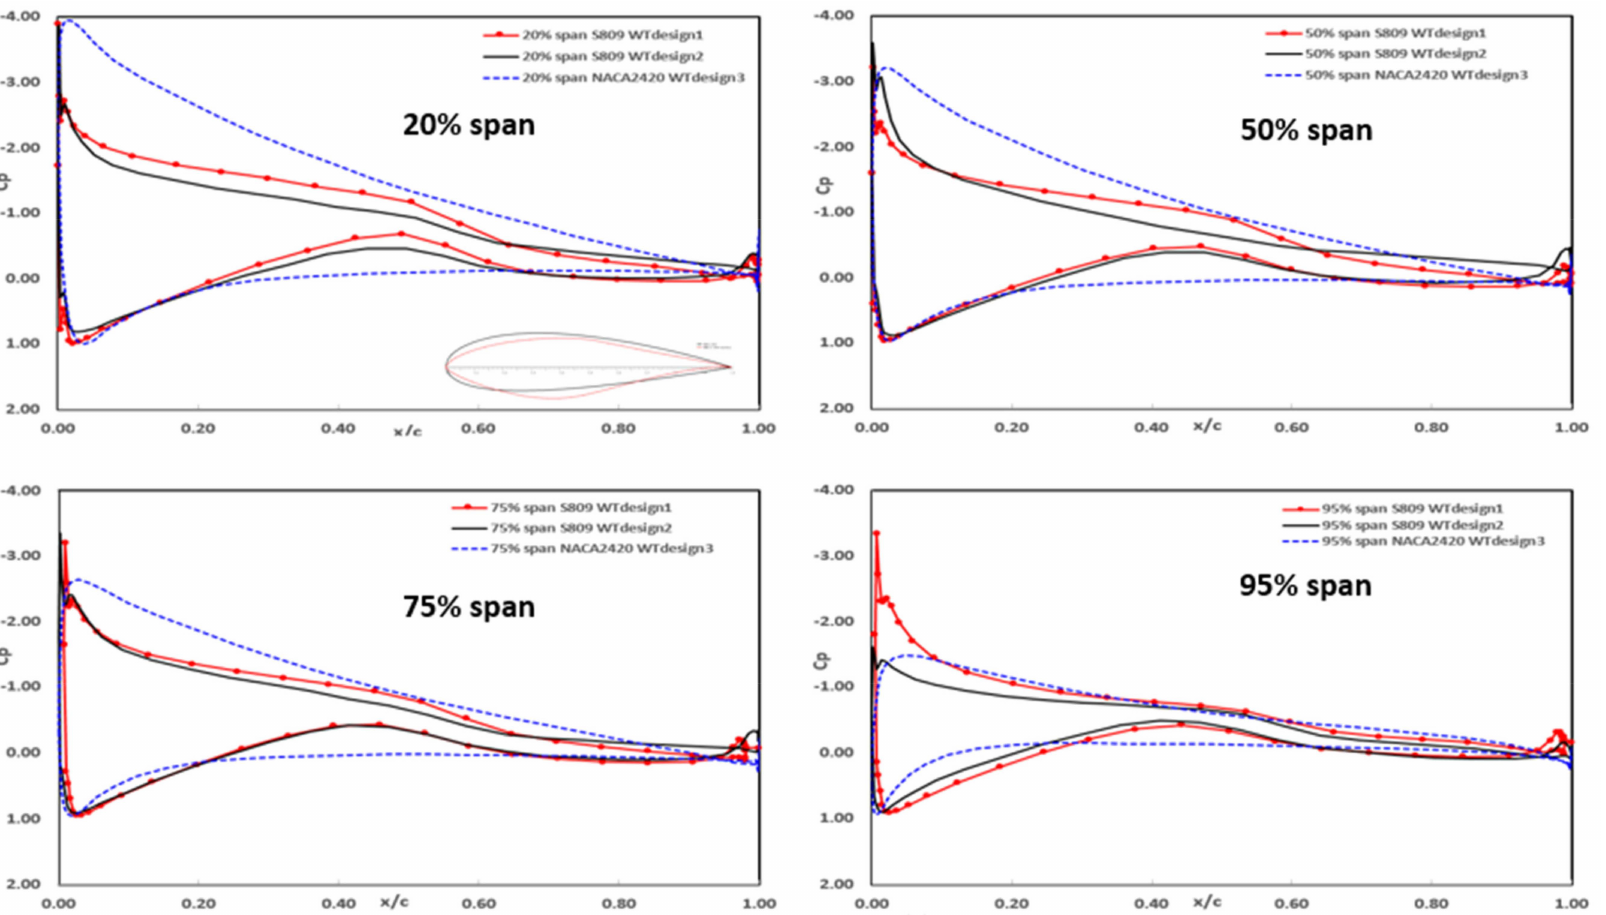
Figure 27. Airfoil loading at several spanwise locations for wind turbine rotor designs. Design-3 (blue dotted line) with NACA2420 has the optimal